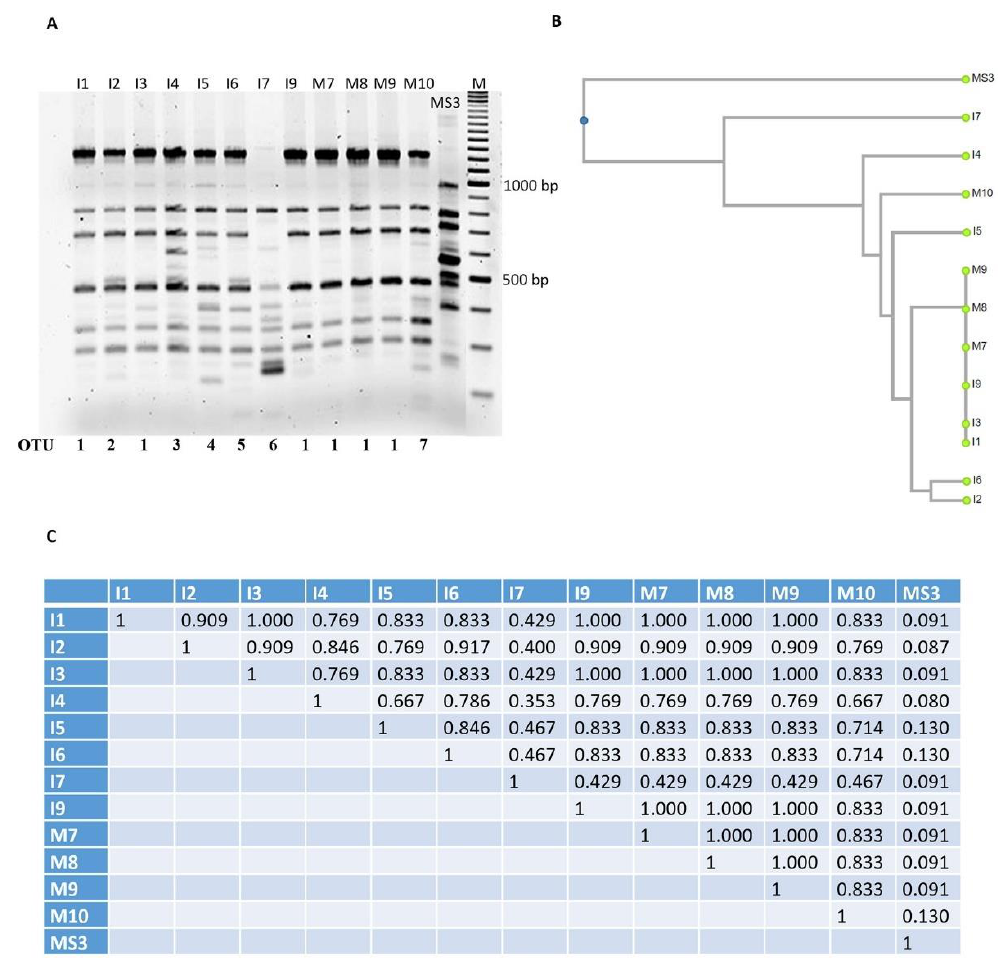
Figure 3. ( A ). RAPD patterns obtained with primer RAPD1 (see Mat and Met). RAPD-PCR products were obtained from the DNA of different clones of L. lactis subsp. lactis isolated from NWSc (I1, I2, I3, I5, I6, I9, M7, M8, M9, and M10). L. lactis subsp. cremoris MS3 (lab collection) was used as control. The patterns are grouped in clusters (OTU, Operational Taxo- nomic Units) according to the unweighted pair group method algorithm with arithmetic mean (UPGMA) analysis. ( B ). Dendrogram obtained from RAPD- PCR patterns, based on the Jaccard’s similarity coefficient, shown in panel ( C ). ( C ). Genetic similarity matrix of the analyzed clones, based on RAPD data and computed using Jaccard’s coefficient (UPGMA